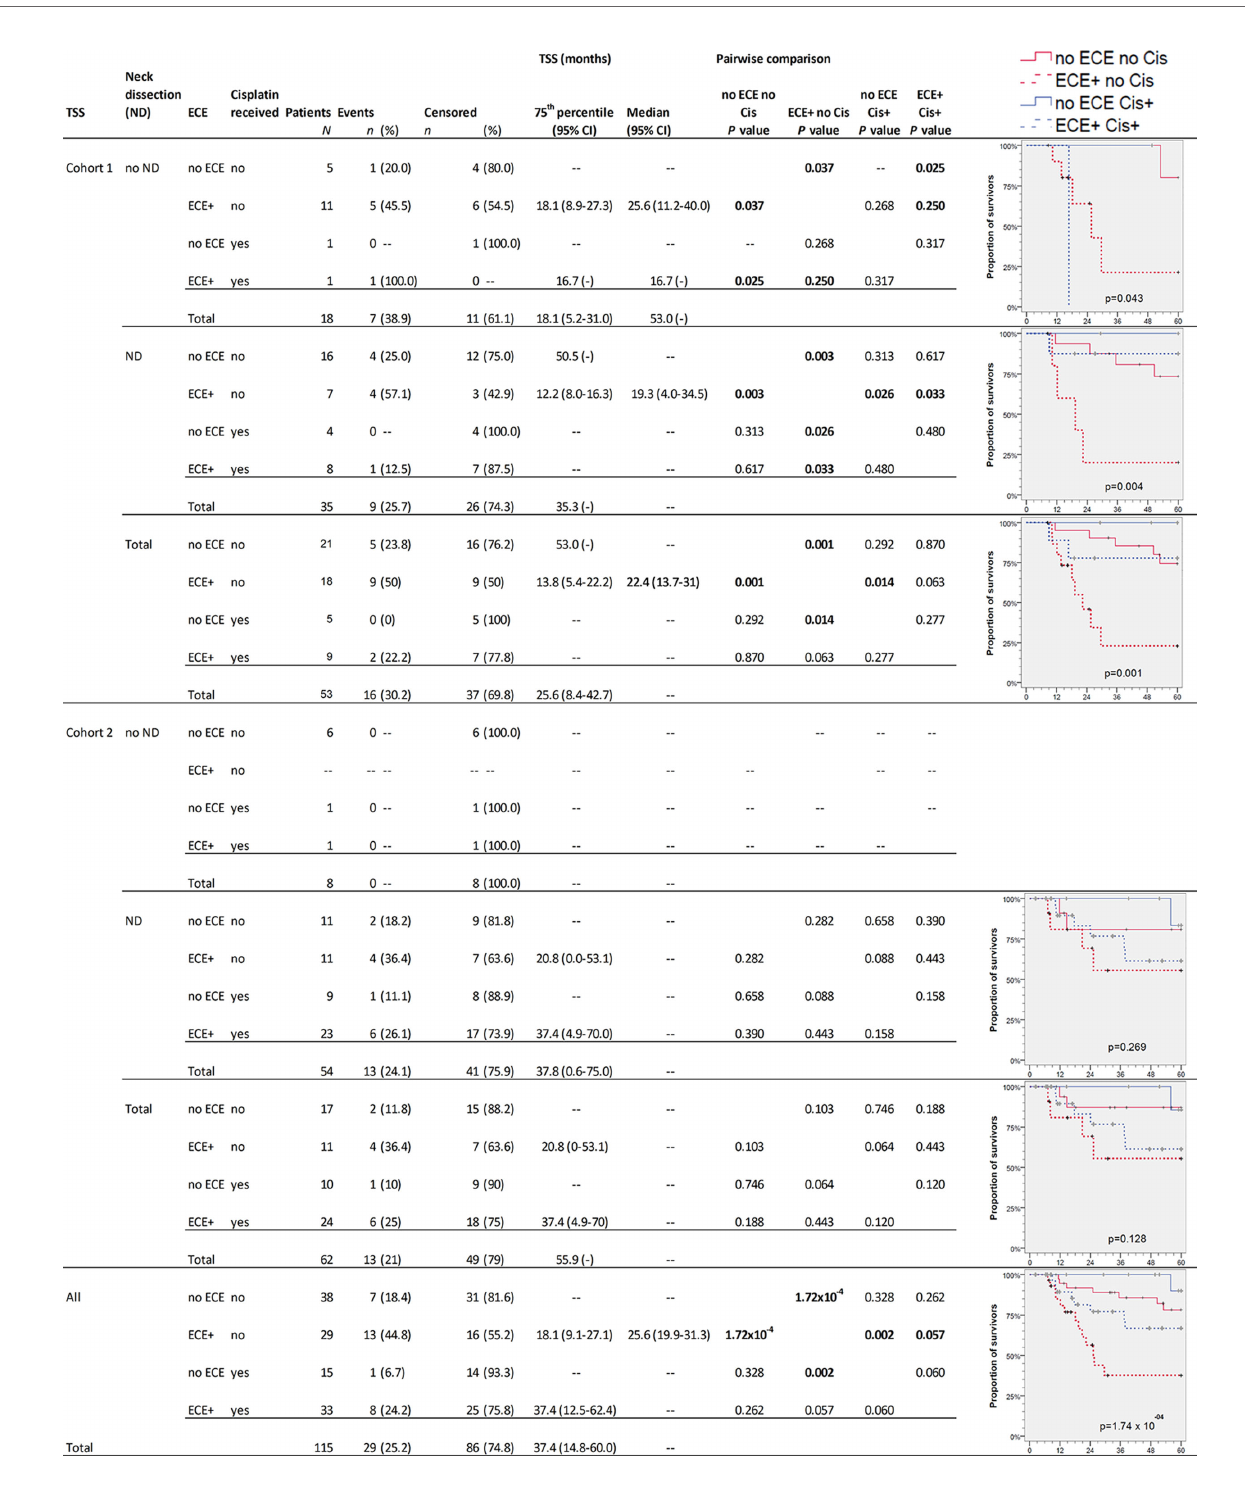
FIGURE 4 | Kaplan – Meier cumulative survival (KM) plots for tumor-speci fi c survival (TSS) of squamous cell carcinoma of unknown primary patients (NSCCUP-P) demonstrate the improved outcome achieved by standardized treatment including neck dissection (ND) and cisplatin-based radio-chemotherapy (Cis+) for NSCCUP-P with extracapsular extension of neck nodes (ECE). Besides KM plots, the numbers of patients and events are shown with 75th percentile and median along with their respective 95% con fi dence interval (95% CI) together with P -values from pairwise comparisons in various strata combining ND, ECE and Cis in cohorts 1 and 2 as well as for all